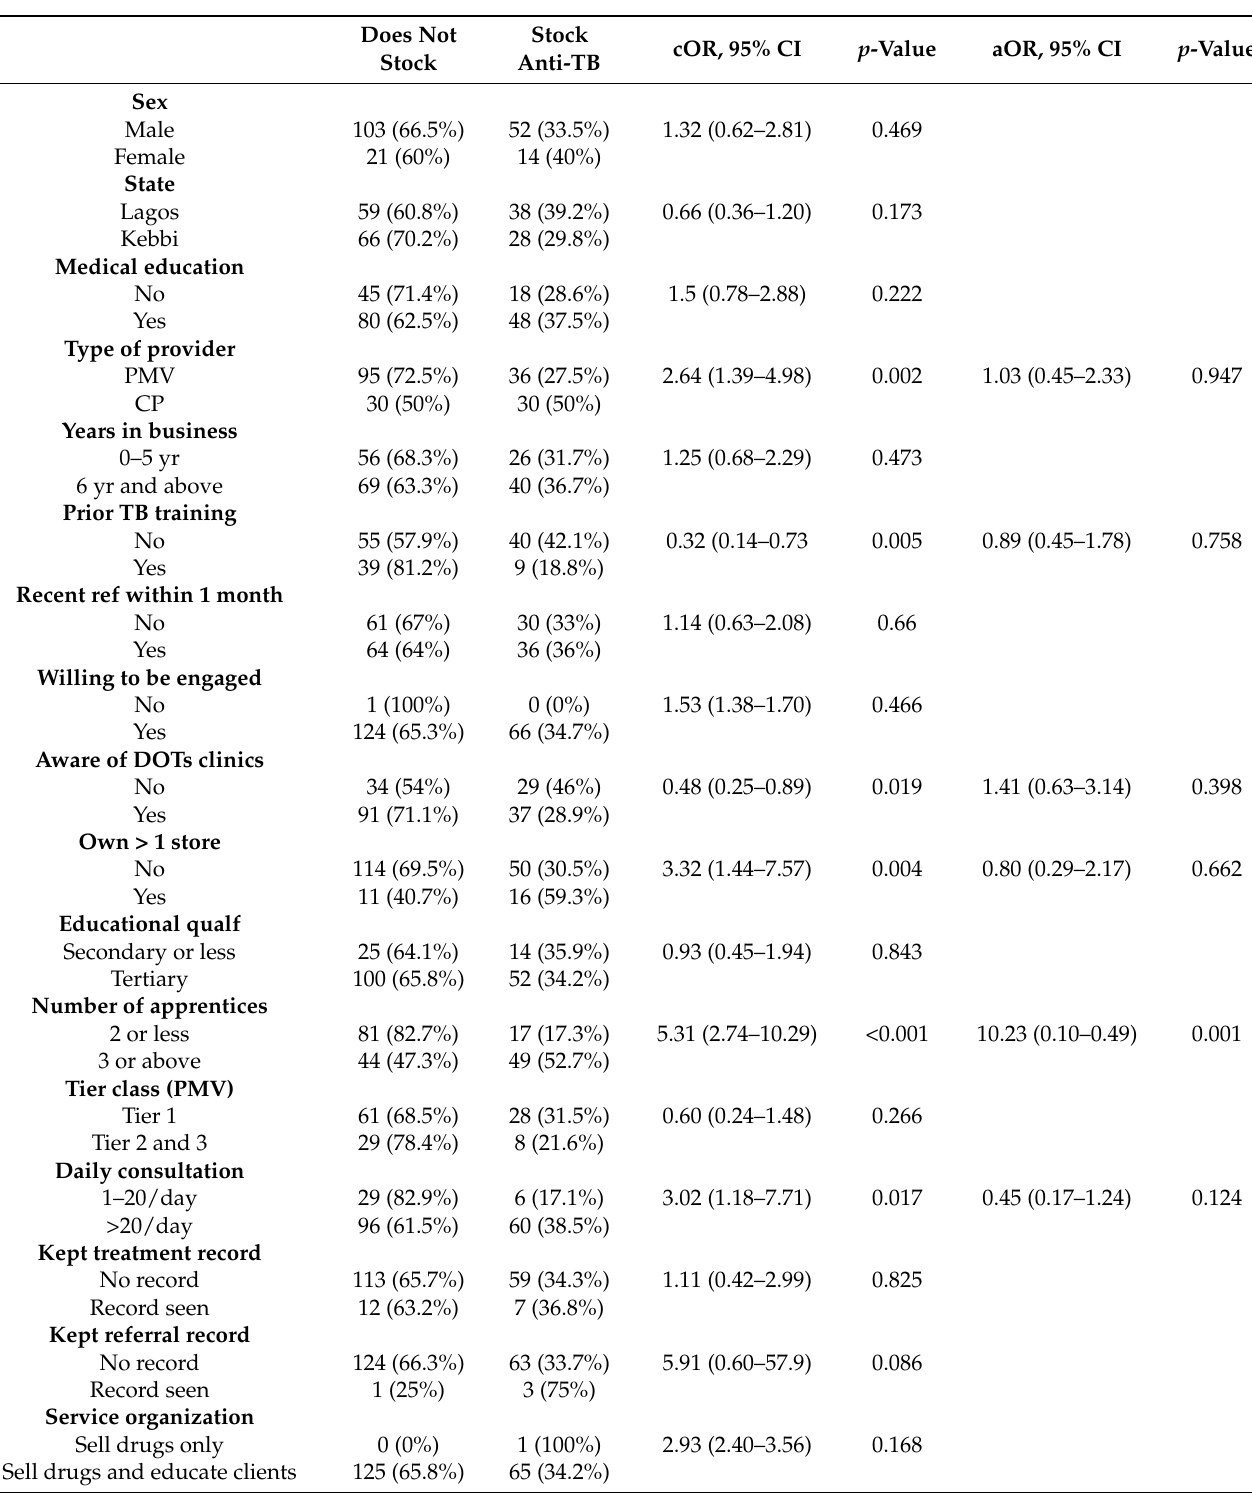
Table 3. Bivariate analysis of anti-TB stocking practice and associated